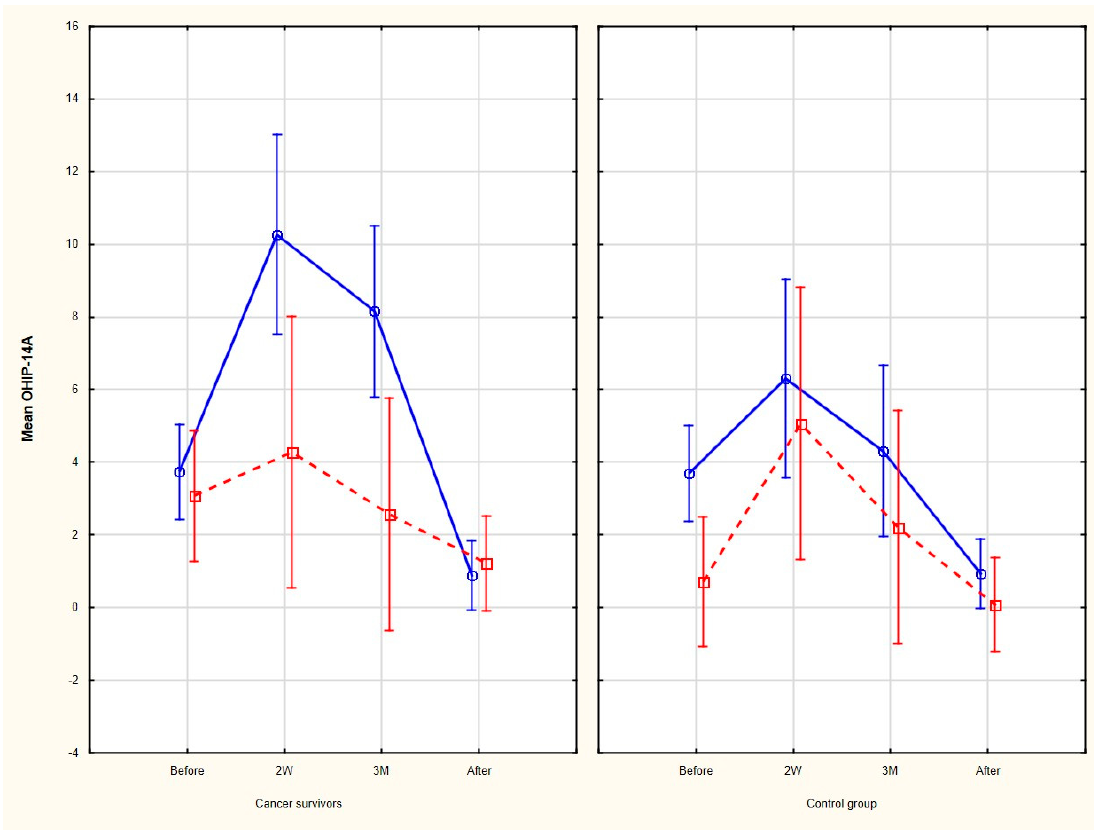
Figure 3. Gender differences in OHIP-14 total score in the cancer survivors’ and control groups (male patients are depicted with blue line and female patients with red dotted line). Here, 2W—2 weeks after the onset of the treatment, 3M—3 months after the onset of the treatment, and OHIP-14A—OHIP-14 index scored with the additive method.